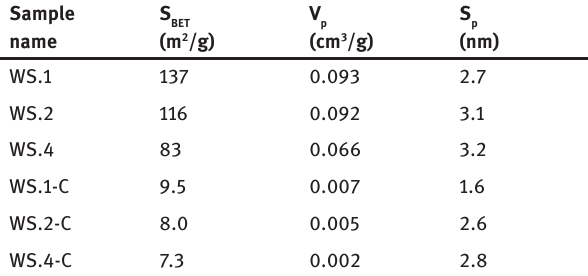
Table 4. Porous structure